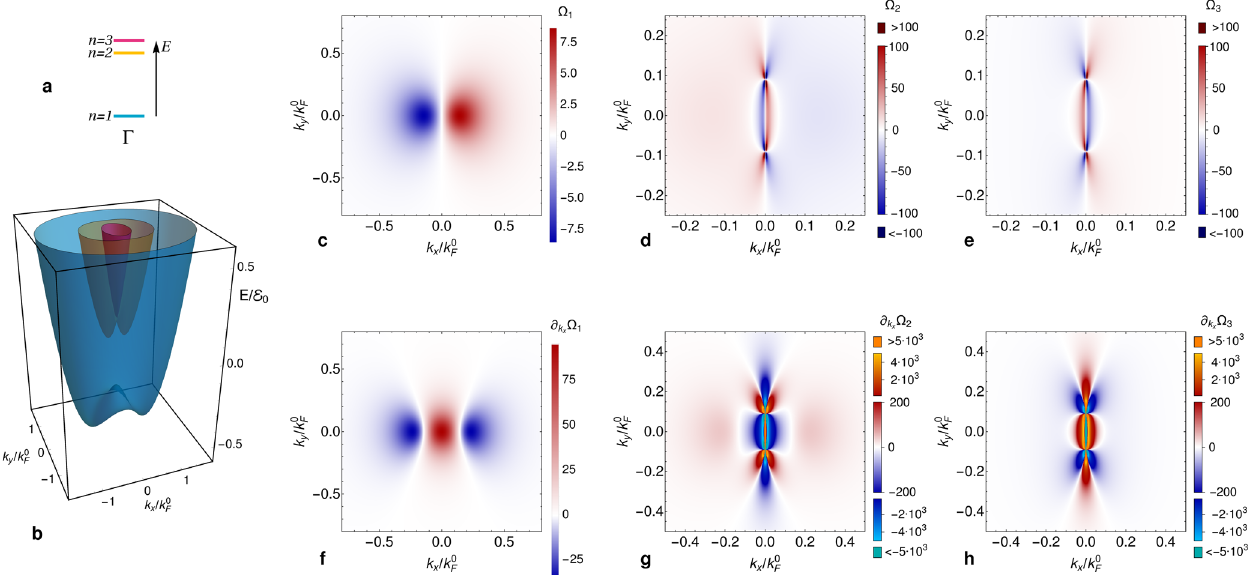
Fig. 3 Orbital design of Berry curvature hot-spots and pinch points. a Ordering of the crystal fi eld split t 2 g ( p ) orbitals with their associated band index. b Energy spectrum of the model Eq. (5) obtained using the parameter set Δ ¼ (cid:2) 0 : 2 E 0 , Δ m ¼ 0 : 01 E 0 , α R ¼ α m ¼ 1 : 0 E 0 = k 0 c – e show the ensuing band-resolved Berry curvature. f – h are the corresponding BC dipole densities ∂ k symmetry guarantees that the orthogonal dipole density ∂ k